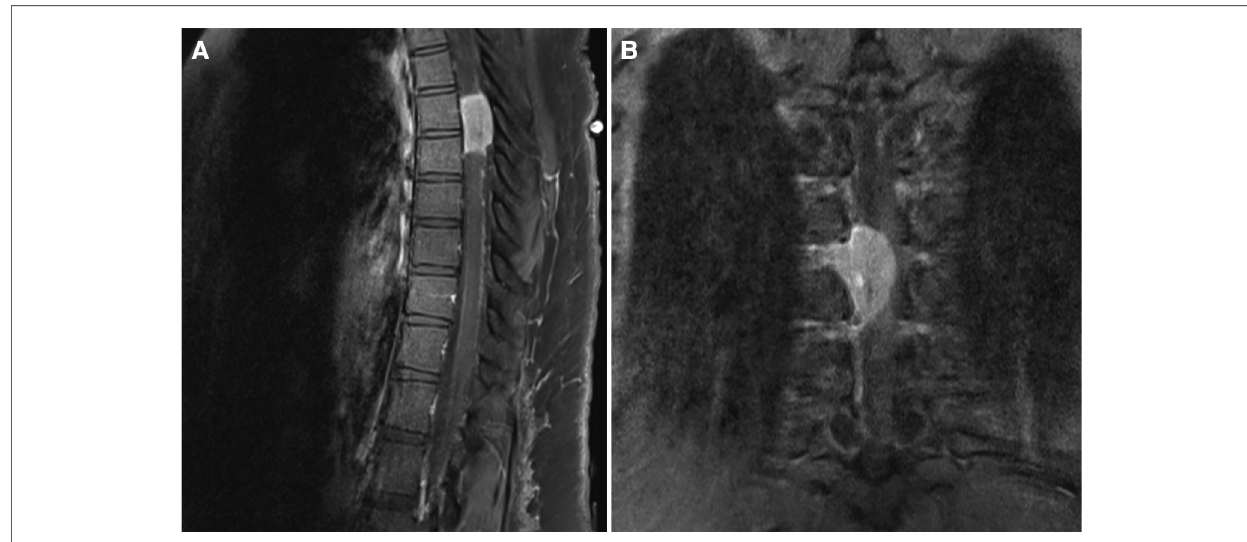
FIGURE 1 ( A ) T1W+contrast MRI sagittal view in a well-de fi ned intradural extramedullary lesion, opposite to the T6/T7 level. ( B ) Hypointense lesion on coronal MRI T1W and enhancing lesion on T1W+contrast, with extension into the right intervertebral foramina, causing spinal cord compression, which exerts a mass effect upon the spinal cord, displacing it to the